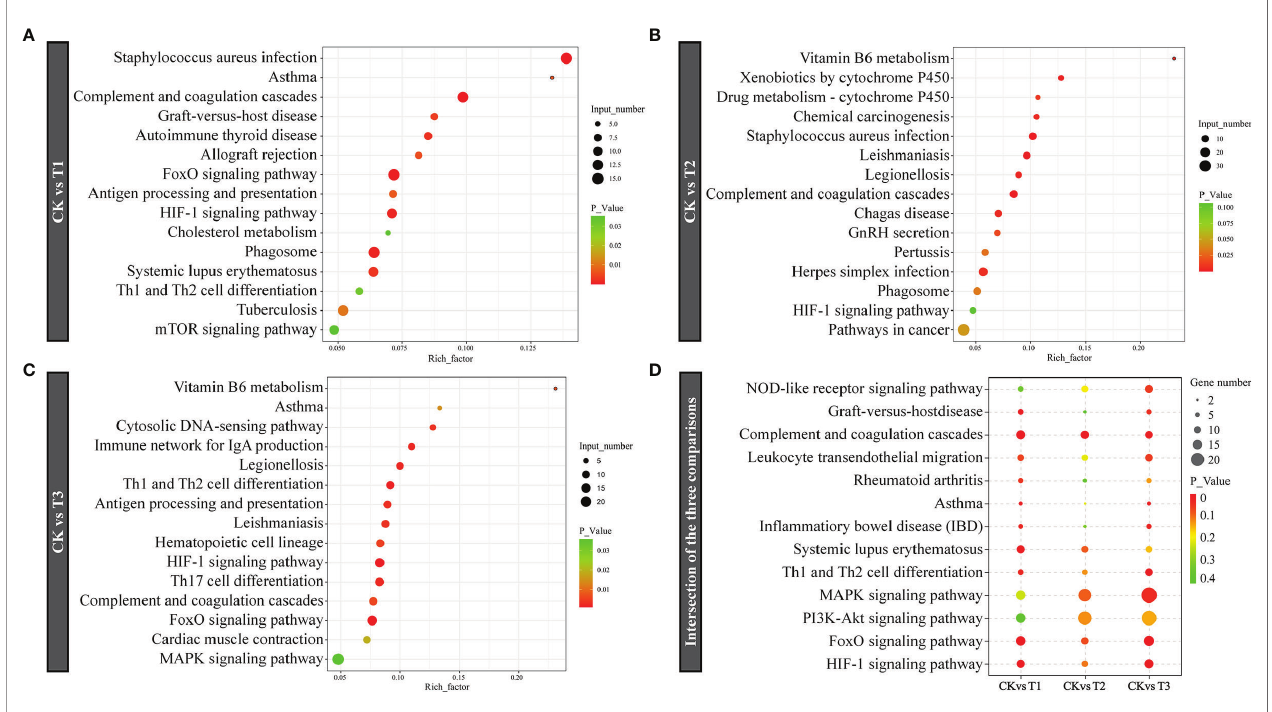
FIGURE 6 | KEGG pathway enrichment of dramatically DEGs in (A) CK vs. T1, (B) CK vs. T2, (C) CK vs. T3, (D) Intersection of the three comparisons in immune response and oxygen transport. The bubble plots highlight KEGG cascades that are considerably enriched in the remarkable DEGs. The y -axis exhibits KEGG cascades. The x -axis denotes the rich factor. The P result signi fi es the signaling cascades enrichment importance; the lower the P -value, the higher the intensity. CK: normoxia, T1: hypoxia, T2: semi-asphyxia, T3: asphyxia.